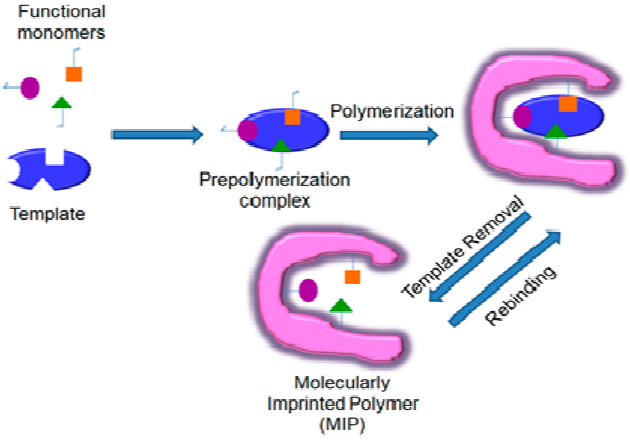
Figure 1. Schematic representation of MIP preparation.